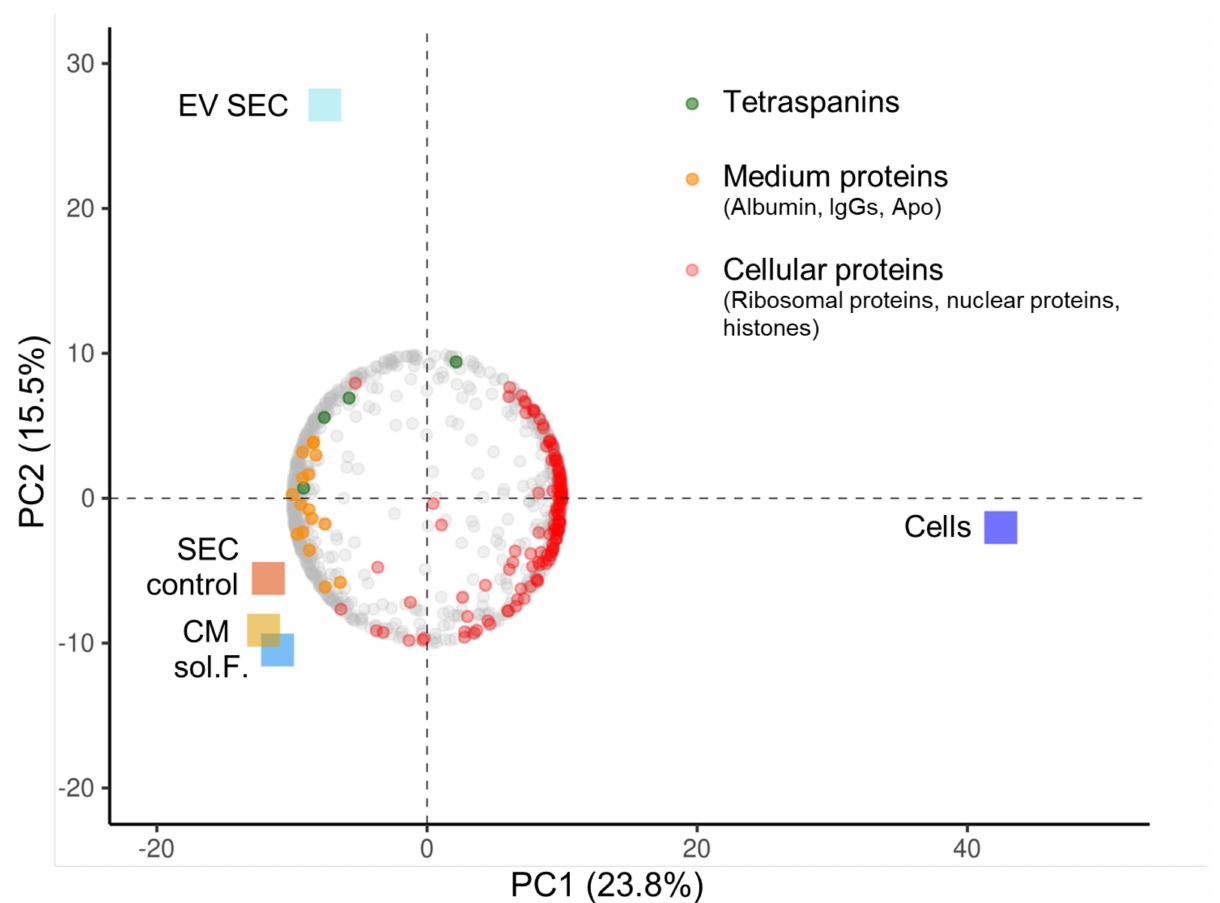
Figure A3. Tandem mass tag proteomics of AML EV fractions. Principle component (PC) analysis biplot showing clustering of the different samples (squares) and the loadings of the 906 variable proteins (circular dots; representing the weights for each original variable—here proteins—when calculating the PC). PC1 showed the strongest separation between cells and other samples (23.8% variance explained) while PC2 separated the size exclusion chromatography-enriched KG1-EVs (EV SEC) from other samples (15.5% variance explained). Protein-rich SEC fraction (SEC control), conditioned media (CM) and soluble factors (sol. F.) were the most similar samples. Individual loadings showed enrichment of tetraspanins (green circles) in the EV SEC fraction. KG1 cells were enriched for cellular proteins (red circles; including histones, ribosomal and nuclear proteins). The cluster “SEC control/CM/sol. F.” was enriched for presumably culture medium-derived proteins (orange circles; albumin, IgGs and apolipoproteins). Five KG-1-derived sample fractions as indicated by colored boxes; mean data, fractions analyzed in